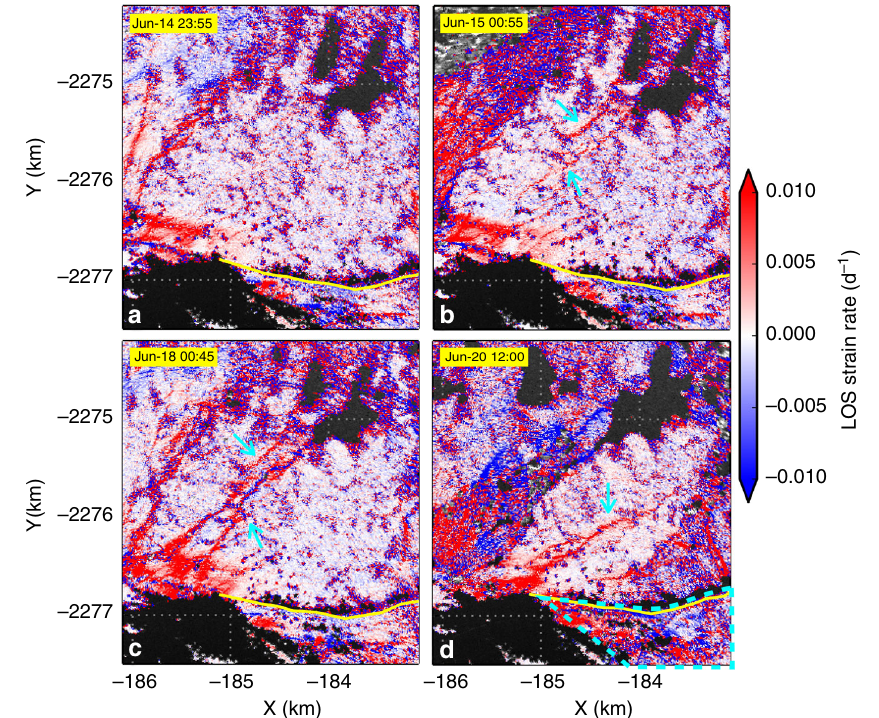
Fig. 9 LOS strain rate responses to calving-like collapses. Strain rates are calculated along line-of-sight directions, based on 30-min median LOS velocity maps derived from interferograms of adjacent radar measurements separated by 2 min. Cyan arrows mark newly formed fi ssures after calving-like collapse events. a , b are at 15 min before and after a major calving-like collapse on 15 June. Fissures in b evolved wider to c and failed on 20 June. The arrow in d marks a strain rate fi ssure by the end of TRI observation period. Dashed cyan in d outlines an area where new high strain rate zones appeared by the end of TRI observations, which is close to the calved area within 1.5 days after the TRI observation period (shaded in blue in Fig. 3k). Map area shown in this fi gure is outlined by the yellow box in Fig. 8a. Yellow lines mark the mélange-glacier boundary